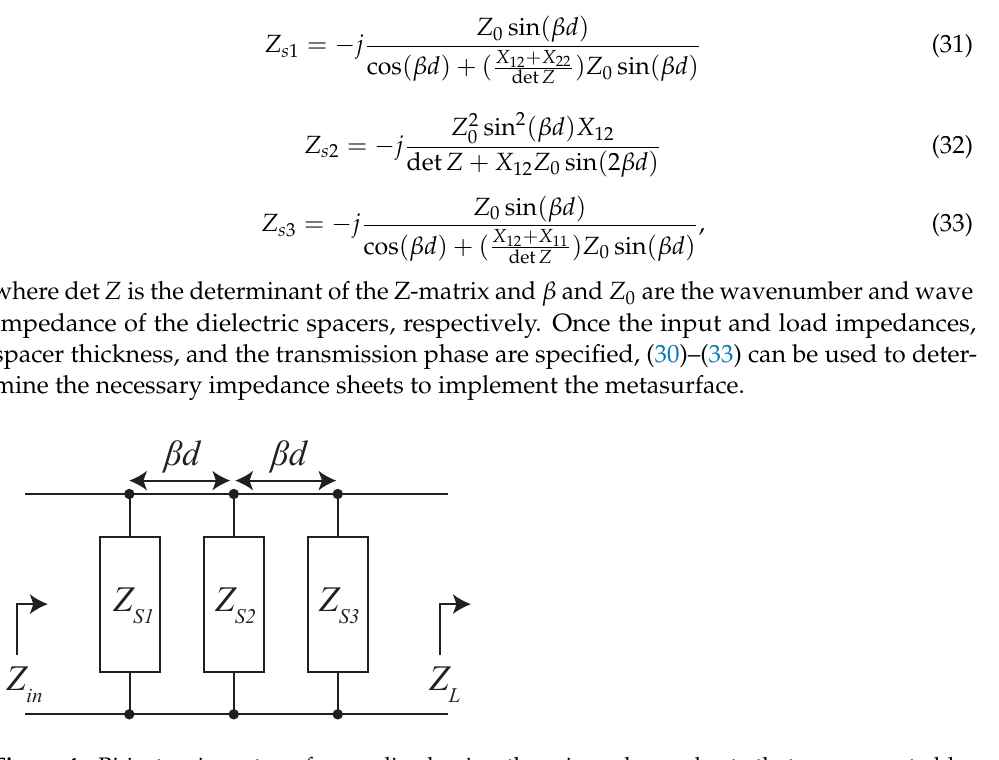
Figure 4. Bi-isotropic metasurface realized using three impedance sheets that are separated by dielectric spacers with thickness